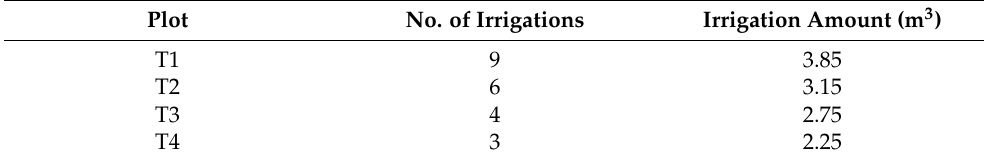
Table 2. Irrigation times and irrigation amounts of experimental plots under different water stresses. Plot